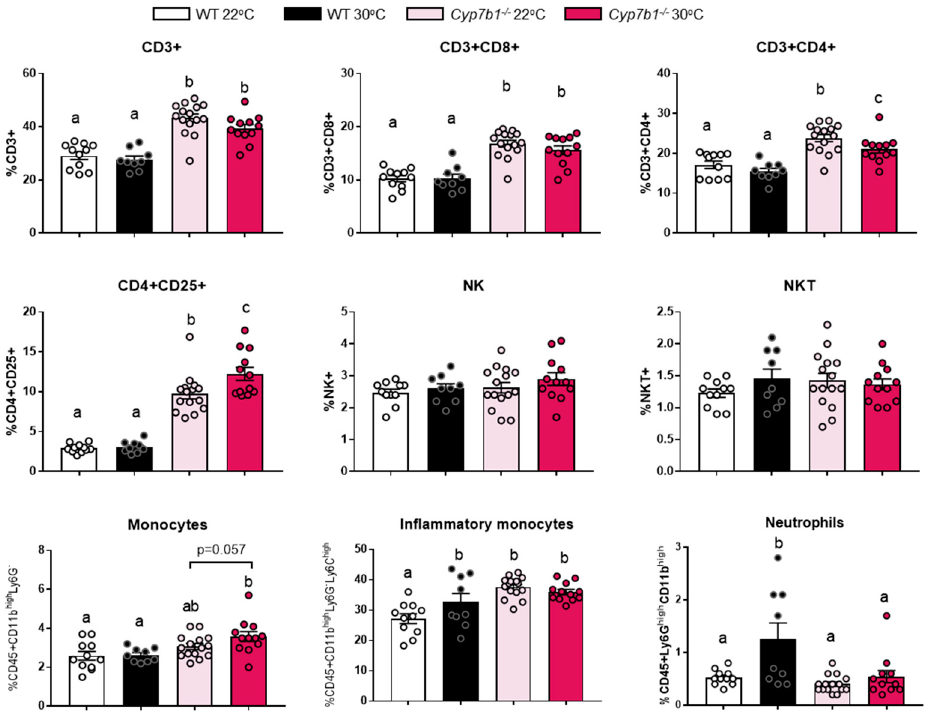
Figure 5. Immune cell profiling of the spleen. Flow cytometry was performed to determine CD3+, CD3+CD8+, CD3+CD4+ and CD4+CD25+ lymphocytes as well as NK, NKT, monocytes, inflamma- tory monocytes and neutrophils in Cyp7b1 − / − and wild littermates type housed under 22 °C or 30 °C, all fed a CD-HFD for 8 months. Data are shown as mean values ± SEM. (number of mice: WT 22 °C: n= 11; WT 30 °C: n = 9; Cyp7b1 − / − 22 °C: n = 15; Cyp7b1 − / − 30 °C: n = 12). Different letters indi- cate significant differences between groups ( p < 0.05) determined by two-way ANOVA.